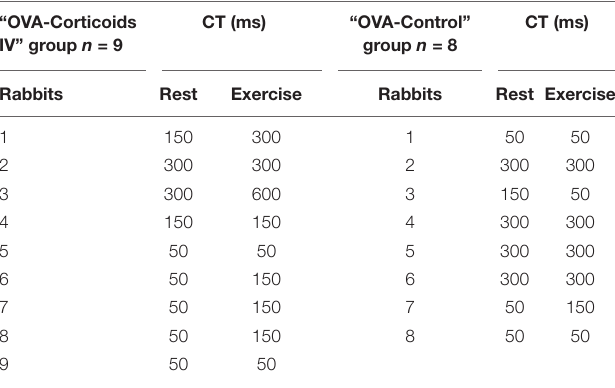
TABLE 1 | Wheal area of the induration extent measured 24 h after the intradermal injection of 100 µ L of an OVA solution (200 µ g/mL) in OVA sensitized rabbits (expressed in mm 2 ).